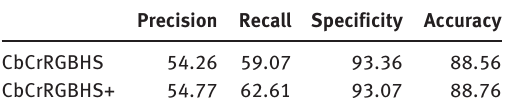
Table 10. Accuracy Results for CbCrRGBHS+ on the VT-AAST